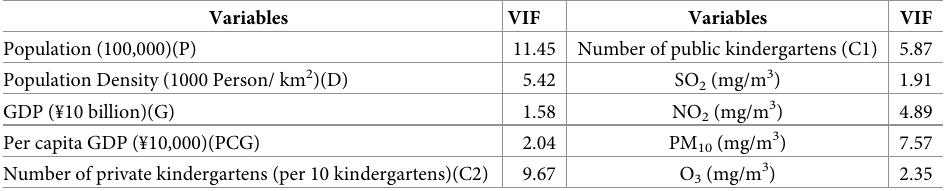
Table 3. Multicollinearity evaluation results (VIF: Variance inflation